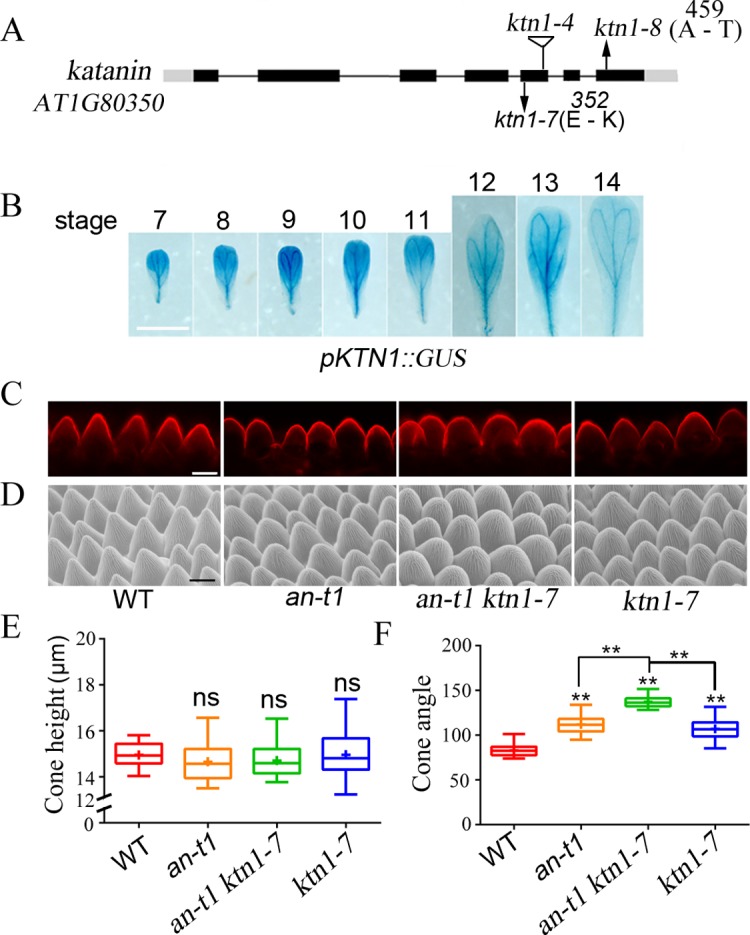
Mutations in KTN1 leading to enhanced conical cell phenotypes of an-t1.(A) Schematic representation of the KTN1 gene, showing the nature and position of the ktn1 mutant alleles. Arrows indicate nucleotide substitutions, and the triangle indicates T-DNA insertion. (B) KTN1 expression activity throughout petal development stages 7 to 14 was monitored by pKTN1:GUS transgene expression. Scale bar = 1 mm. (C and D) Confocal (C) and scanning electron microscope (D) images of conical cells of WT, an-t1, an-t1 ktn1-7, and ktn1-7 from stage 14 mature petals. Scale bars represent 10 μm. (E and F) Quantification of cone height (E) and cone angle (F) of conical cell phenotypes. For the quantification of cone height, ns indicates no significant difference (Mann–Whitney U test, P > 0.05) between the data sets compared with WT Col-0 (P = 0.2633, P = 0.11099, P = 0.31530, respectively). For the quantification of cone angle, asterisks indicate a significant difference (Mann–Whitney U test, **P < 0.01) (for an-t1 vs WT, P = 0.00359; for an-t1 ktn1-7 vs WT, P = 0.00129; for ktn1-7 vs WT, P = 0.0017; for an-t1 ktn1-7 vs an-t1, P = 0.00223; for an-t1 ktn1-7 vs ktn1-7, P = 0.0022). Values are given as the mean ± SD of more than 300 cells from 20 petals.